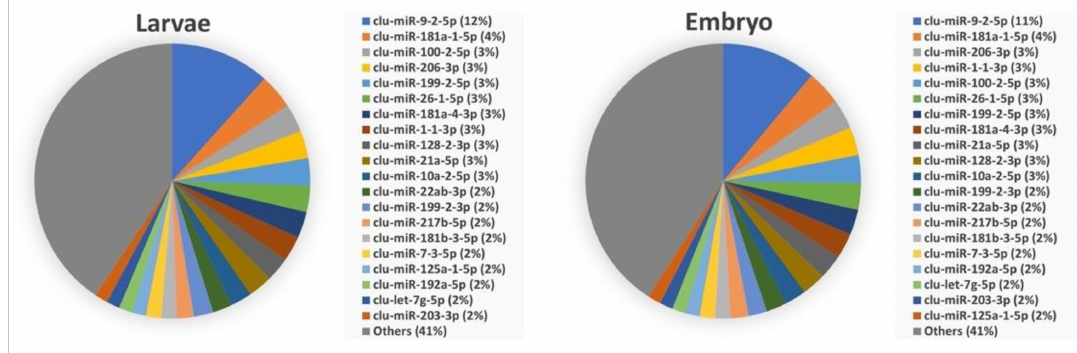
Figure 3. Twenty most abundant miRNAs in lumpfish brain, muscle, gill, liver, spleen, and head kidney.